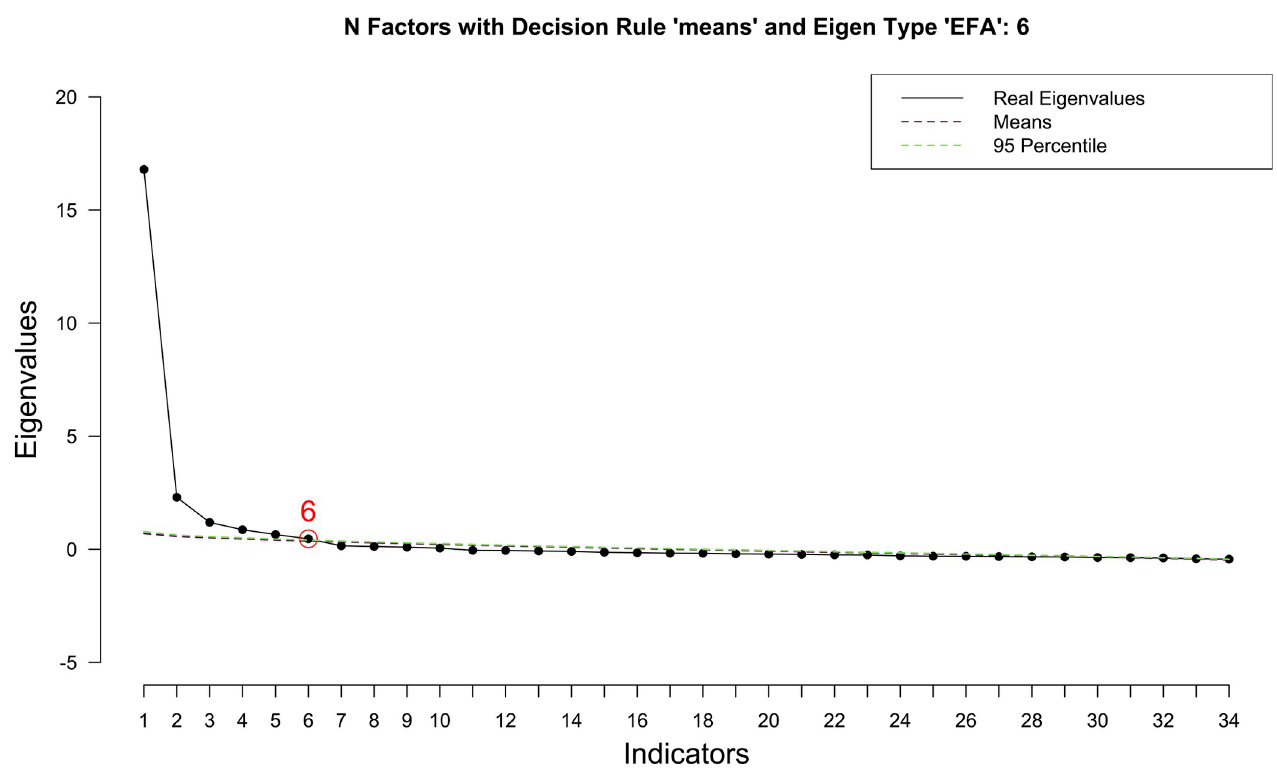
Fig 1. Determining the number of factors to extract using parallel analysis. EFA: Exploratory Factor Analysis.